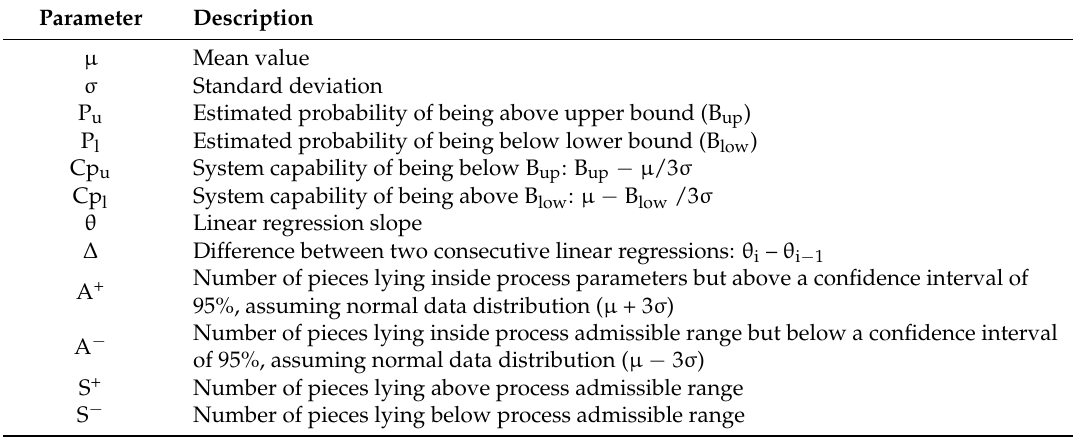
Table 2. Parameters to be combined in PCA to build the tracker. Tracker time series could be considered as the definitive output of data preparation stage and the data stage able to maximize performances of ARIMA